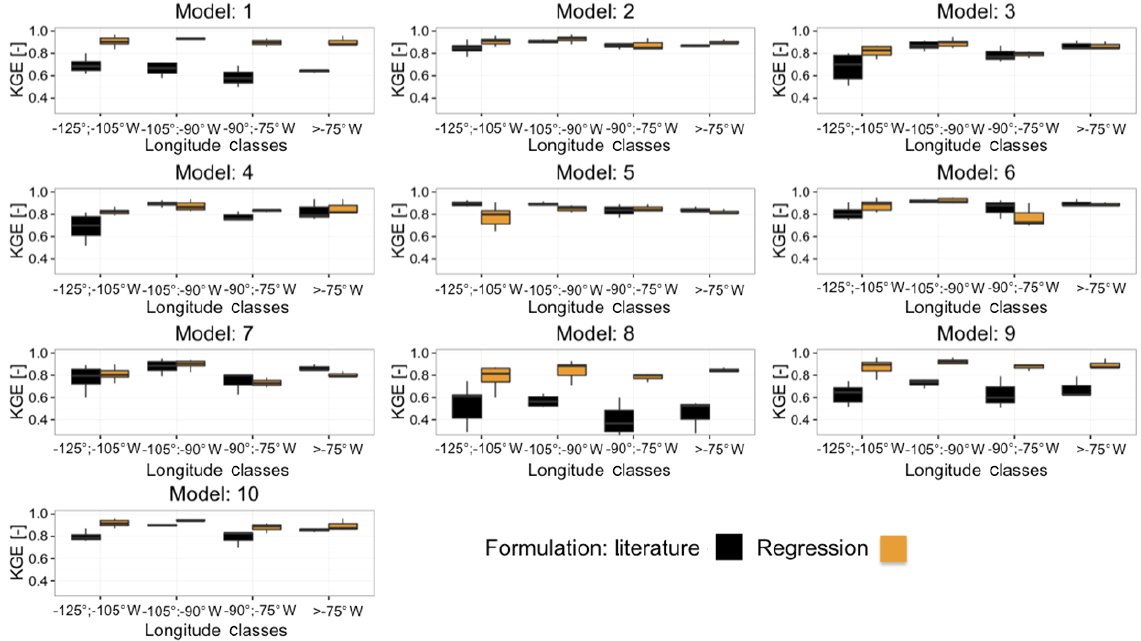
Figure 9. Comparison between model performances obtained with regression and classic parameters: the KGE values shown are those above 0.3 and results are grouped by longitude classes.